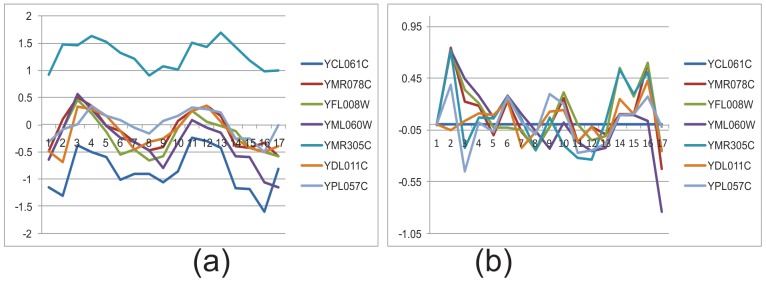
Gene expression level in absolute scale (a) and in relative scale (b).Vertical axis represents expression level normalized by z-score. Horizontal axis represents conditions or time points (1–17).